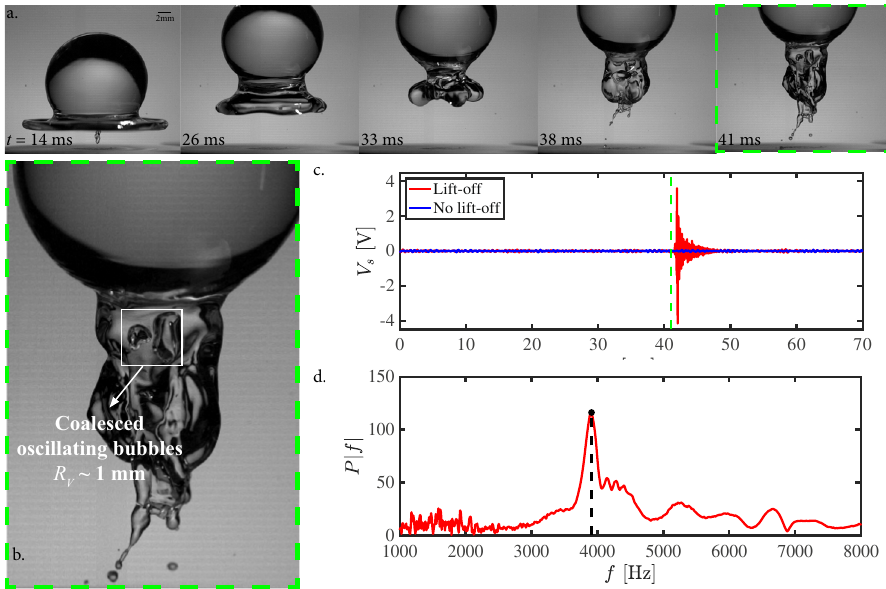
Fig. 4 Bubble capture and collapse in mid-air through droplet retraction in lift-off cases. a Image sequence showing the retraction phase of the droplet. The hydrogel sphere impacts a droplet (volume, V = 0.30 mL) at time t = 0 with an impacting velocity of 1.17 m/s. The droplet bounces off and reaches the maximum spreading radius at t = 14 ms. Afterwards, the rim starts to retract inwards with the upwards motion of the rebounding sphere, a reverse cone develops with several spherical fi ngers at the edge of the rim ( t = 26 ms – 33 ms). This hollow cone collapses on itself ( t = 38 ms) trapping a signi fi cant amount of air inside the resultant liquid jet ( t = 38 – 41 ms). b The air inside coalesces into a large bubble (white box) of radius R V , that oscillates at resonance frequency. c The oscillation is captured in the microphone as an acoustic signal. Acoustic signal captured for a no lift-off case is also plotted for comparison. As the no lift-off case show no bubble capture (Fig. 1f), no discernible sounds are measured. 0 ms marks the time of sphere impact. d A power spectrum indicates a resonance frequency f s ~ 4